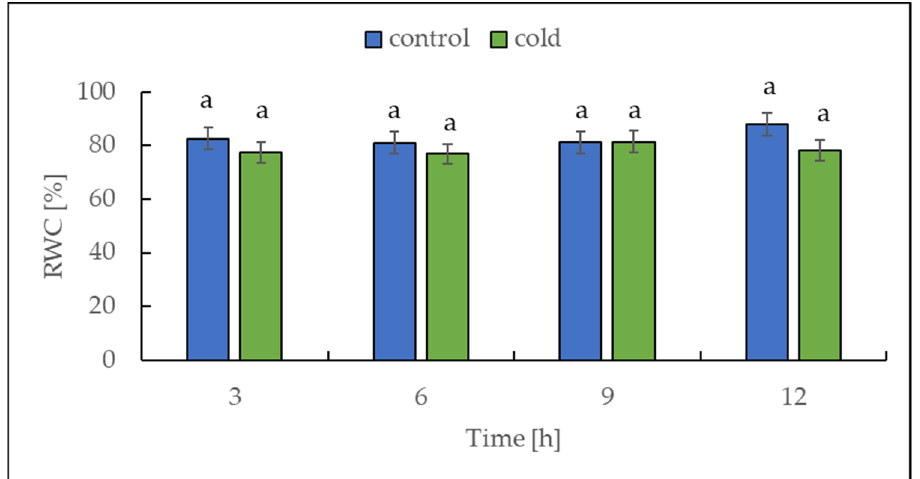
Figure 2. Relative water content (RWC) from potato leaves growing under optimum conditions and exposed to low temperature. The results are the means of at least three biological replicates ± SD. Different letters at the top of the bars indicate significant differences, which were calculated ( p ≤ 0.05) according to Tukey’s HD (honestly significant difference) post hoc test.